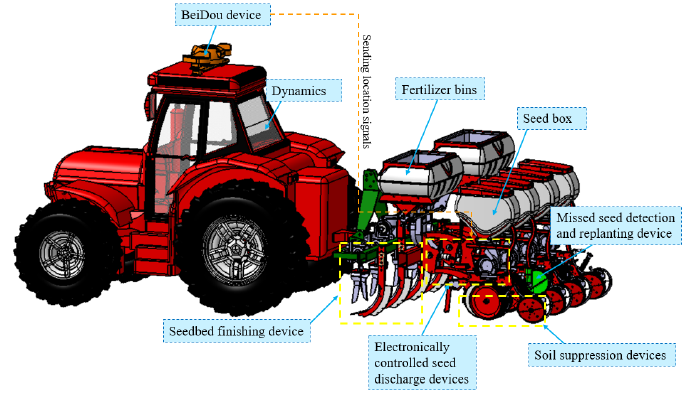
Figure 1. “Tractor, air-suction maize planter, missed seed detection and replanting” complete ma- chine. The schematic diagram of the proposed corn missed sowing detection and compen- sation system is shown in Figure 2. The system consists of the rotary encoder (CDX Tech- nology, Shenzhen, China), air-absorbing seed discharger (Dahua Bolai, Shandong, China), fiber optic sensor (BOJKE, Shenzhen, China), replenishment stepping motor (PFDE, Shen- zhen China), and replenishment seed rower (Laoliang, Hebei, China). The maize air-ab- sorbing seed discharger mainly consists of a seedbox, seed scraper, air chamber, seed dis- persal disc, seed dispersal shaft, and other parts. The installation location and device pa- rameters are shown in Figure 2. The maize precision sowing detection and compensation system can be divided into four main parts: detection system module, control system module, display system module, and actuation system module. The detection system module consists of a fiber optic sensor and a rotary encoder for real-time monitoring of the sowing operation, collecting information such as missed sowing signals and operating speed in real time. The control module, as the system’s core module, processes the signals the detection module receives and sends instructions to the execution module to make the corresponding response. The STM32F407 microcontroller (Texas Instruments, Dezhou, China) is the most critical component of the control module. The display system module is mainly used for the real-time display of seeder operating data such as seeder travel speed, theoretical grain distance, total sowing volume, missed sowing volume, and res- owing volume. The actuation system module consists of a seeding absence compensation system and an alarm system. The sowing compensation system compensates for sowing leakage, and the alarm system alerts you to malfunctioning seed dispensers and blocks seed guide tubes.